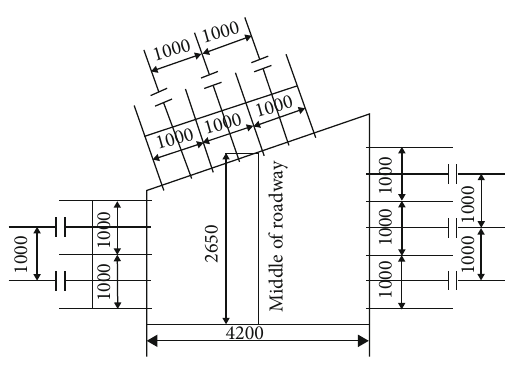
Figure 5: Combined